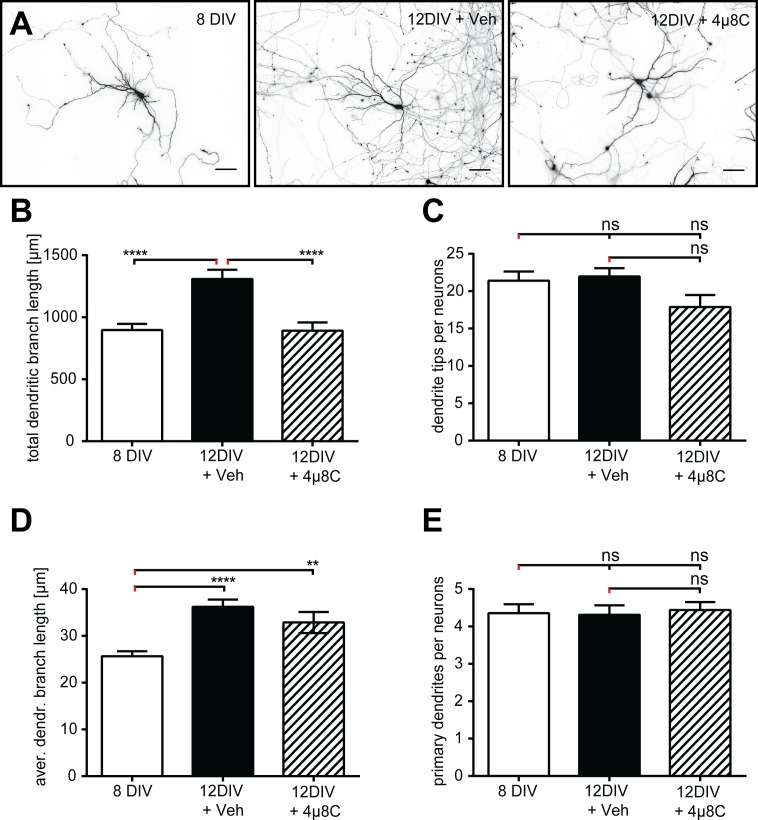
IRE-1 is required for dendrite growth in dissociated hippocampal neurons.A. Images of dissociated hippocampal neurons at indicated days in vitro (DIV) and either DMSO-vehicle control treated (Veh) or treated with an inhibitor of IRE-1 (4μ8C). Scale bars indicate 50 μm. B. Total dendritic branch length increases from 8 to 12 DIV in control neurons and this increase is blocked in 4μ8C-treated cultures. C. Dendrite tip number did not increase with development, however 4μ8C-treated cultures exhibited a non-significant trend towards reduced tip number reflecting decreased dendrite complexity. D. Average dendritic branch length increased from 8 to 12 DIV, and this was not affected by 4μ8C treatment. E. Primary dendrite number was stable from 8 to 12 DIV and was not affected by 4μ8C treatment. 8 DIV, 42 neurons; 12 DIV + Veh, 42 neurons; 12 DIV + 4μ8C, 41 neurons. All data are from three independent experiments. **p < .01; ***p < .001; ****p < .0001; ns, not significant (p > 0.05).